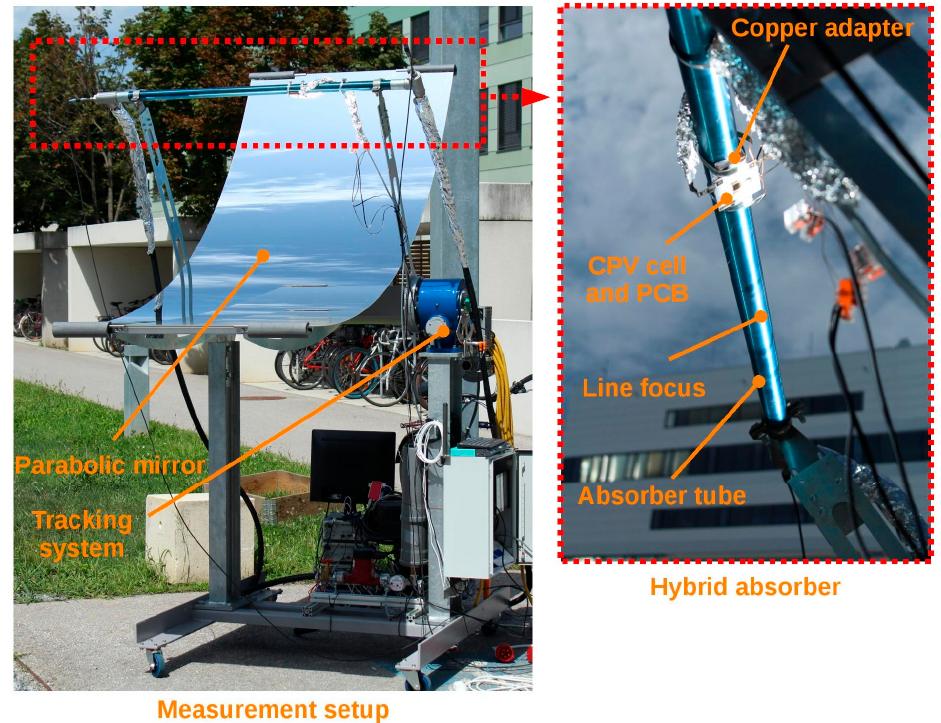
Figure 14. Test setup of the CPV-T hybrid system. Left: Parabolic mirror with the tracking system and the measurement setup. Right: Closer focus on the hybrid absorber with the visible line focus and the multi-junction cell.